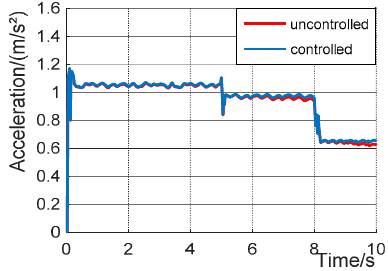
Figure 17. Acceleration curve.